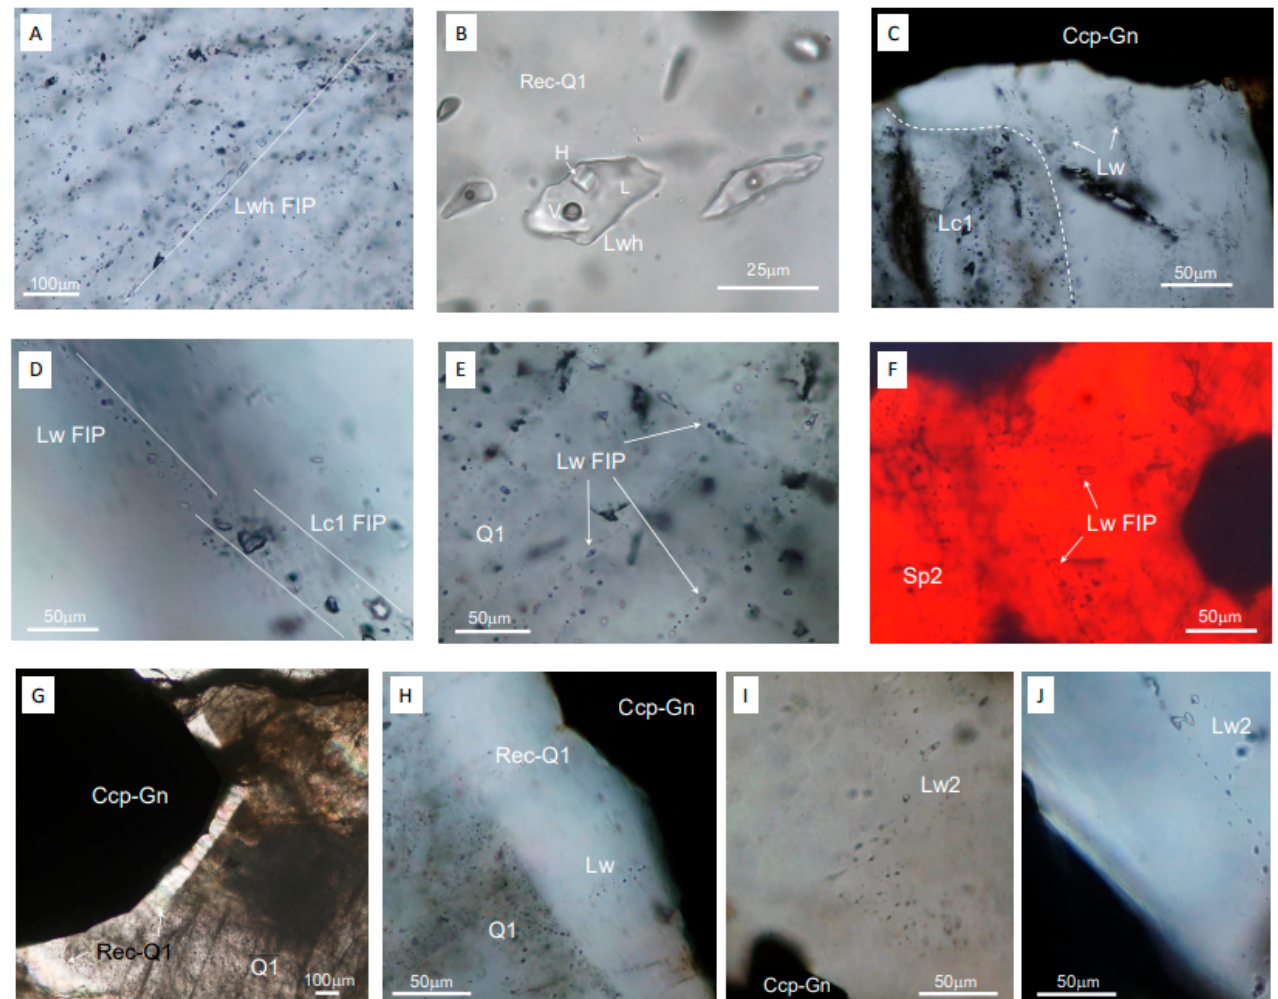
Figure 9. Fluid inclusions from Koudiat Aïcha: late vein stages. ( A , B ): Lwh FIs in microfractures (fluid inclusion planes (FIPs)) crosscutting quartz 1 from early veins (( B ) is a detail of ( A )). ( C ): Lw FIs in recrystallized quartz around chalcopyrite–galena assemblages (Ccp-Gn); Lc1 FIs are exclusively present in early dark quartz. ( D ): Lw aligned in a reworked early Lc1 FIP crosscutting recrystallized Q1. ( E ): Lw FIP crosscutting Q1. ( F ): Lw FIP crosscutting sphalerite 2 (Sp2). ( G , H ): Chalcopyrite-and-galena (Ccp-Gn)-dominated mineral assemblage (late vein stage) surrounded with recrystallized quartz containing primary Lw FIs. ( I , J ): Lw2 FIs in clear quartz around chalcopyrite and galena (Ccp-Gn) assemblages.